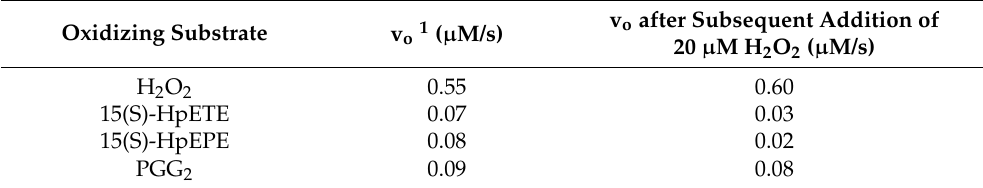
Table 1. Catalytic activity of Hs Prx3 using different oxidizing